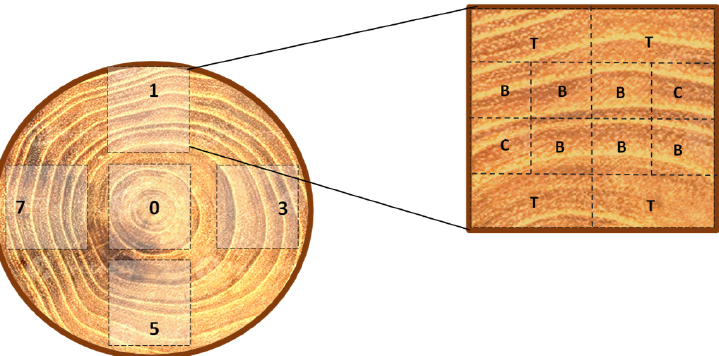
Figure 2. Location of specimens obtained: B = bending strength, C = axial compression strength, T = tension parallel to grain.